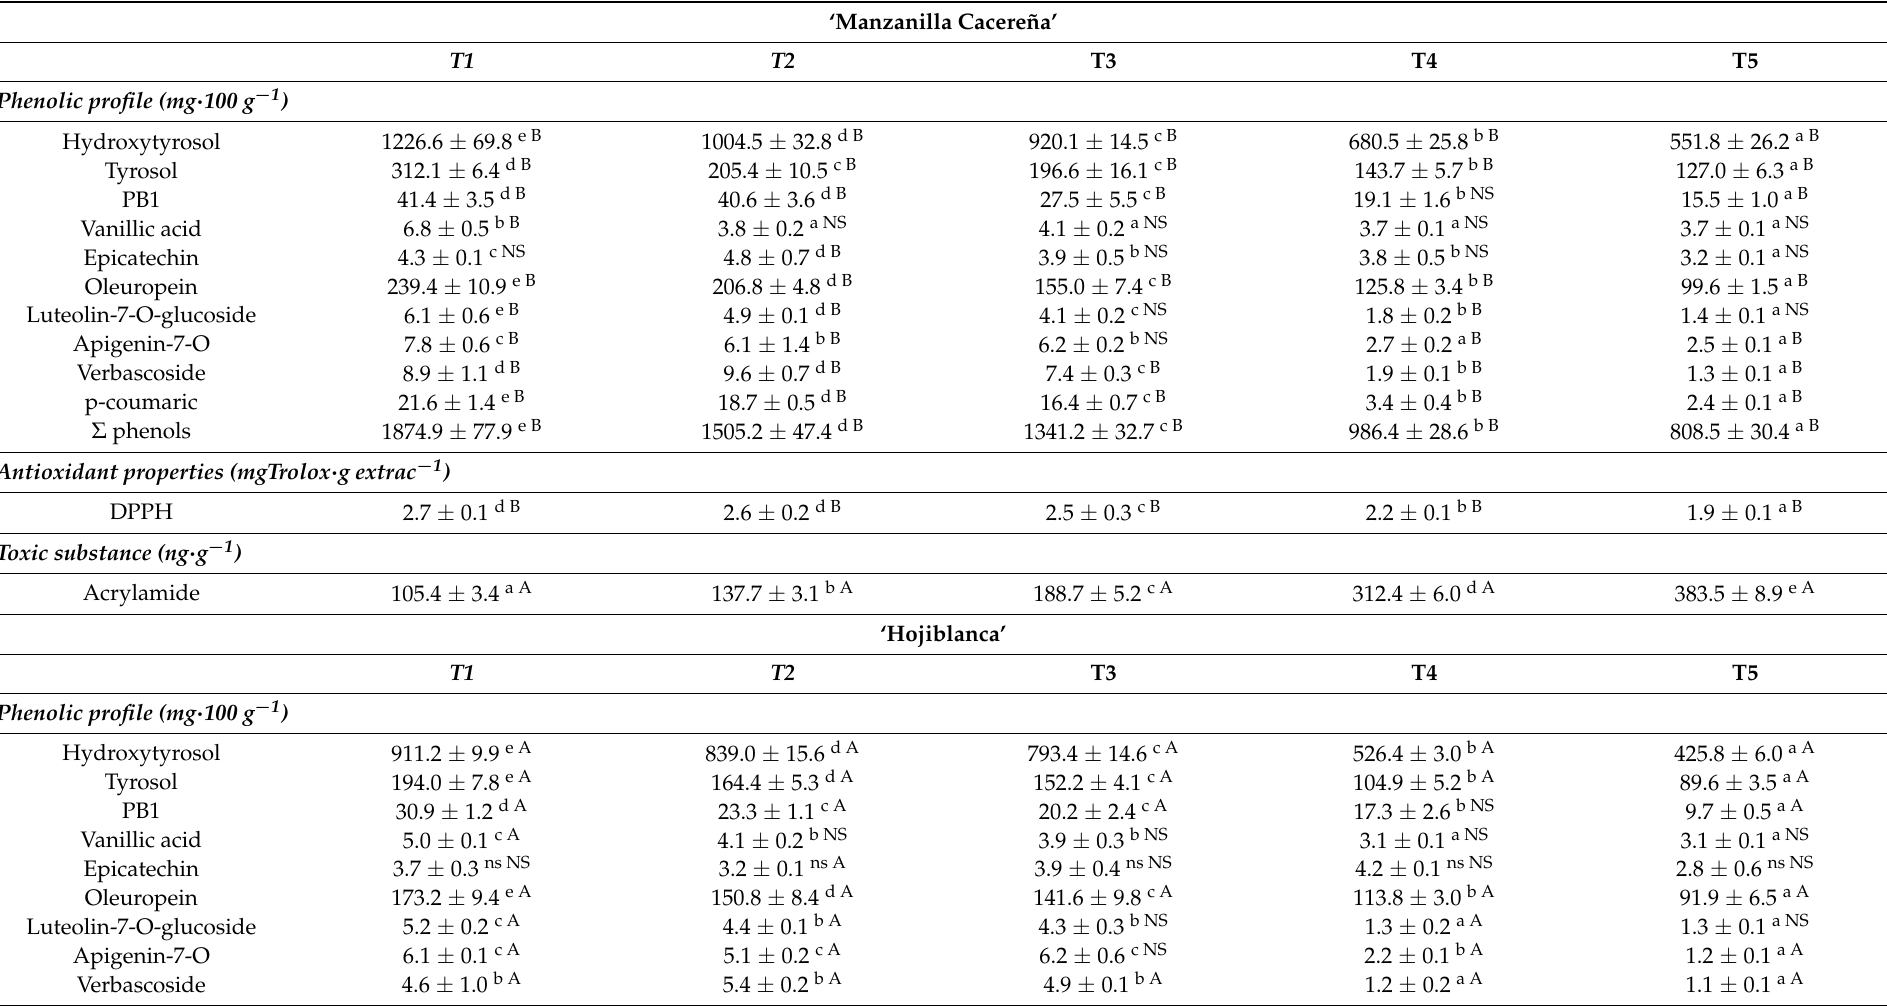
Table 1. Chemical composition of Californian-style black olives (“Manzanilla Cacereña” and “Hojiblanca”) submitted to different thermal sterilization treatments. Results are expressed as mean ± SD of three sample replicates. For the same cultivar, different lowercase letters mean a statistically significant difference between thermal treatment (one-way ANOVA followed by Tukey’s test, p <